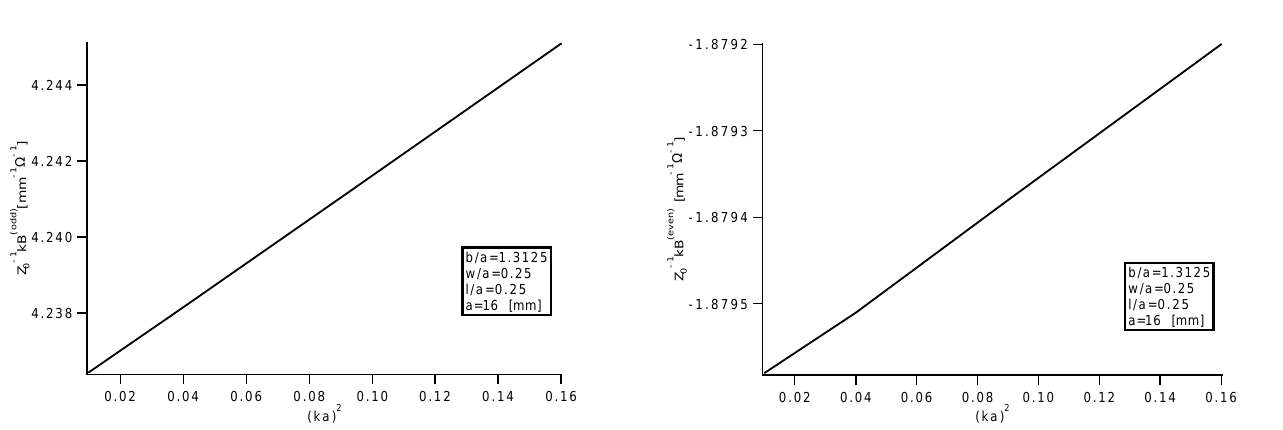
FIG. 2. Magnetic part of the imaginary admittance at low